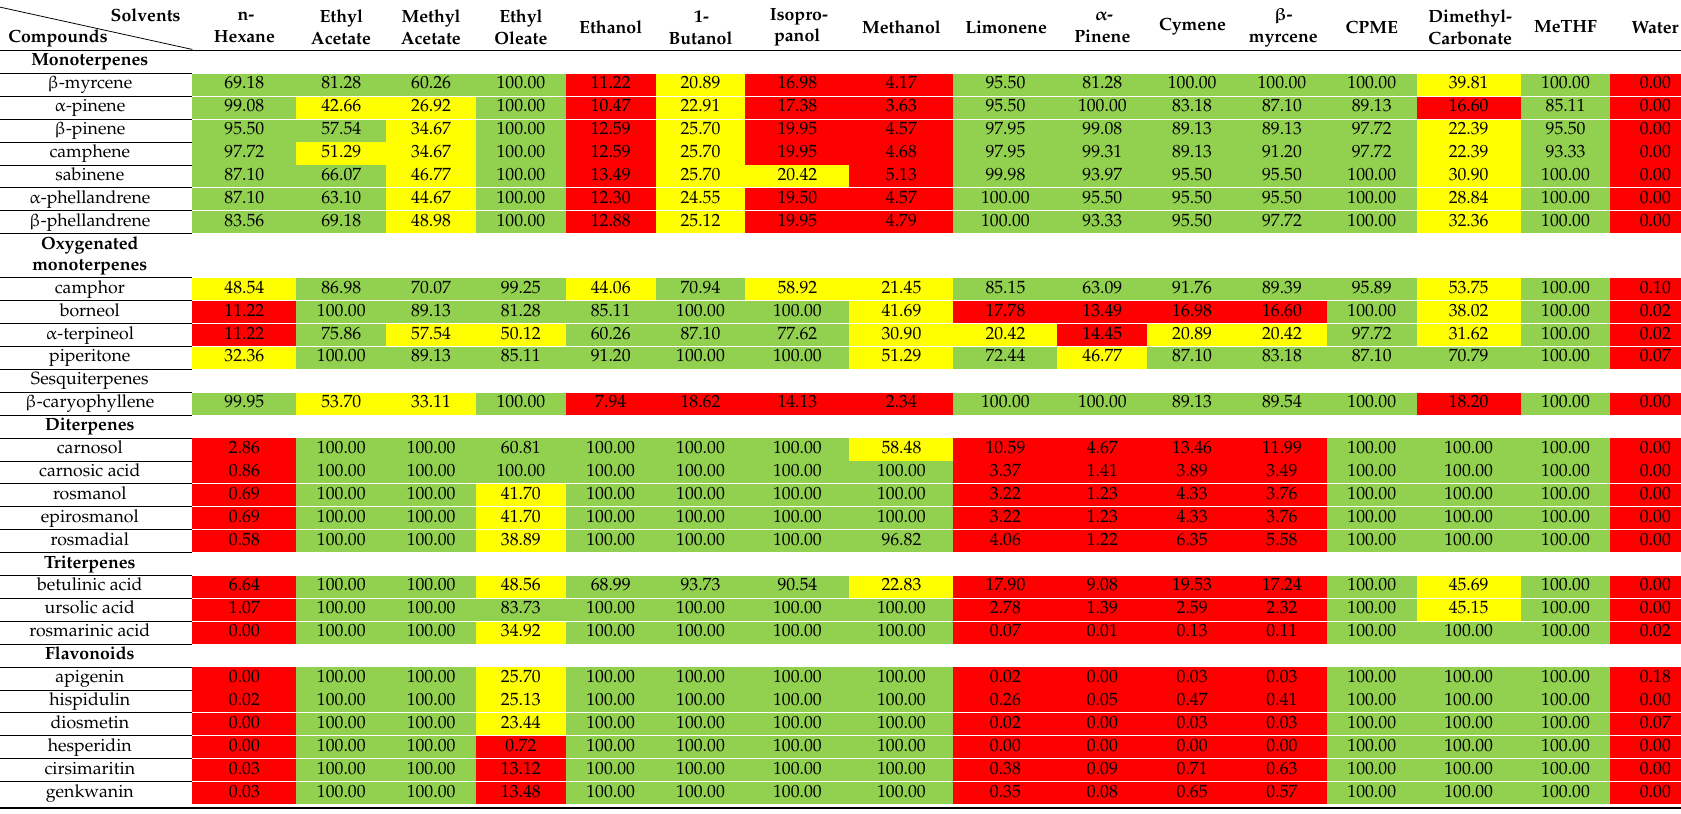
Table 2. Conductor-like screening model for real solvents (COSMO–RS) probability of solubility (%) of bioactive compounds from rosemary for di ff erent solvents. CompoundsSolvents n- Ethyl Methyl Ethyl Hexane Acetate Acetate Oleate Monoterpenes β -myrcene